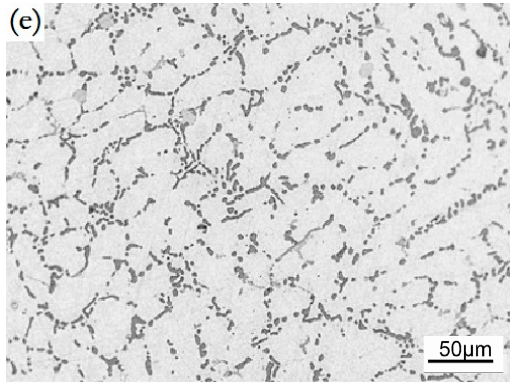
Figure 2. Microstructure of the Ho-modified A356 aluminum alloys in T6 state, ( a ) unmodified; ( b ) 0.1 wt.%; ( c ) 0.2 wt.%; ( d ) 0.3 wt.%; ( e ) 0.4 wt.%.